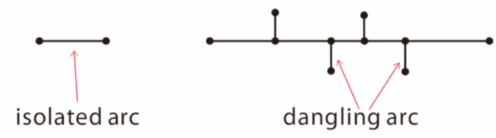
Figure 6. Isolated arcs and dangling